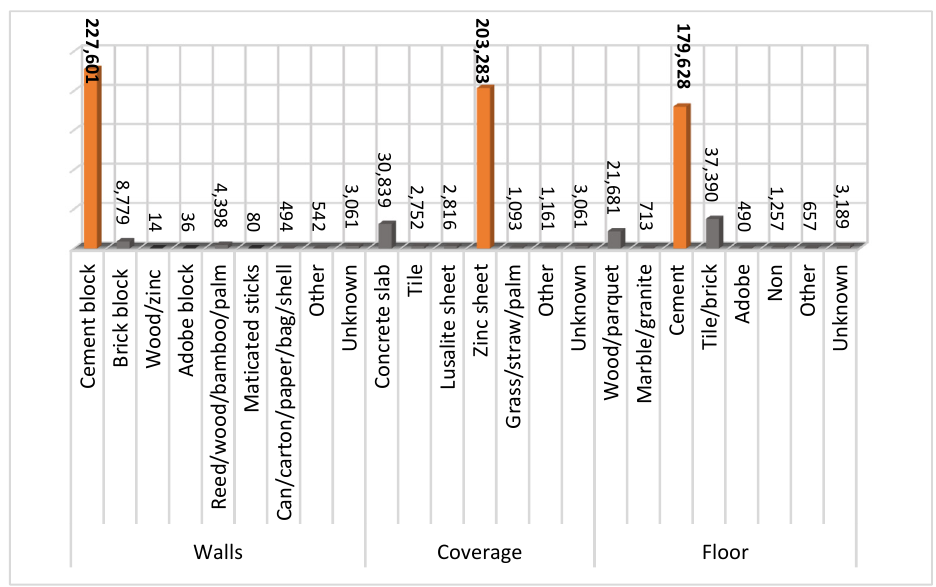
Figure 4. Housing construction materials in Maputo City (source: [104]).